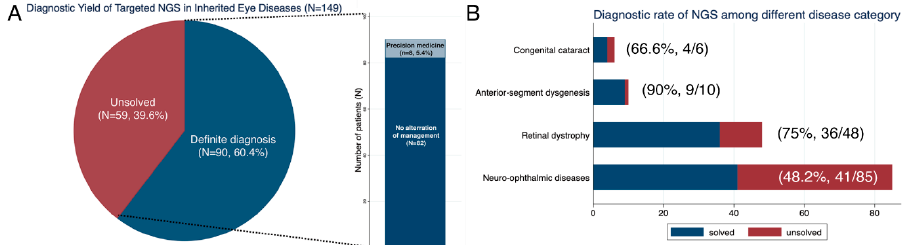
Figure 1. Diagnostic rate of targeted next-generation sequencing (NGS) in inherited eye diseases. ( A ) Overall diagnostic rate of targeted NGS and the proportion of patients who received precision medicine after genetic testing. ( B ) Diagnostic rate of targeted NGS among each disease category.